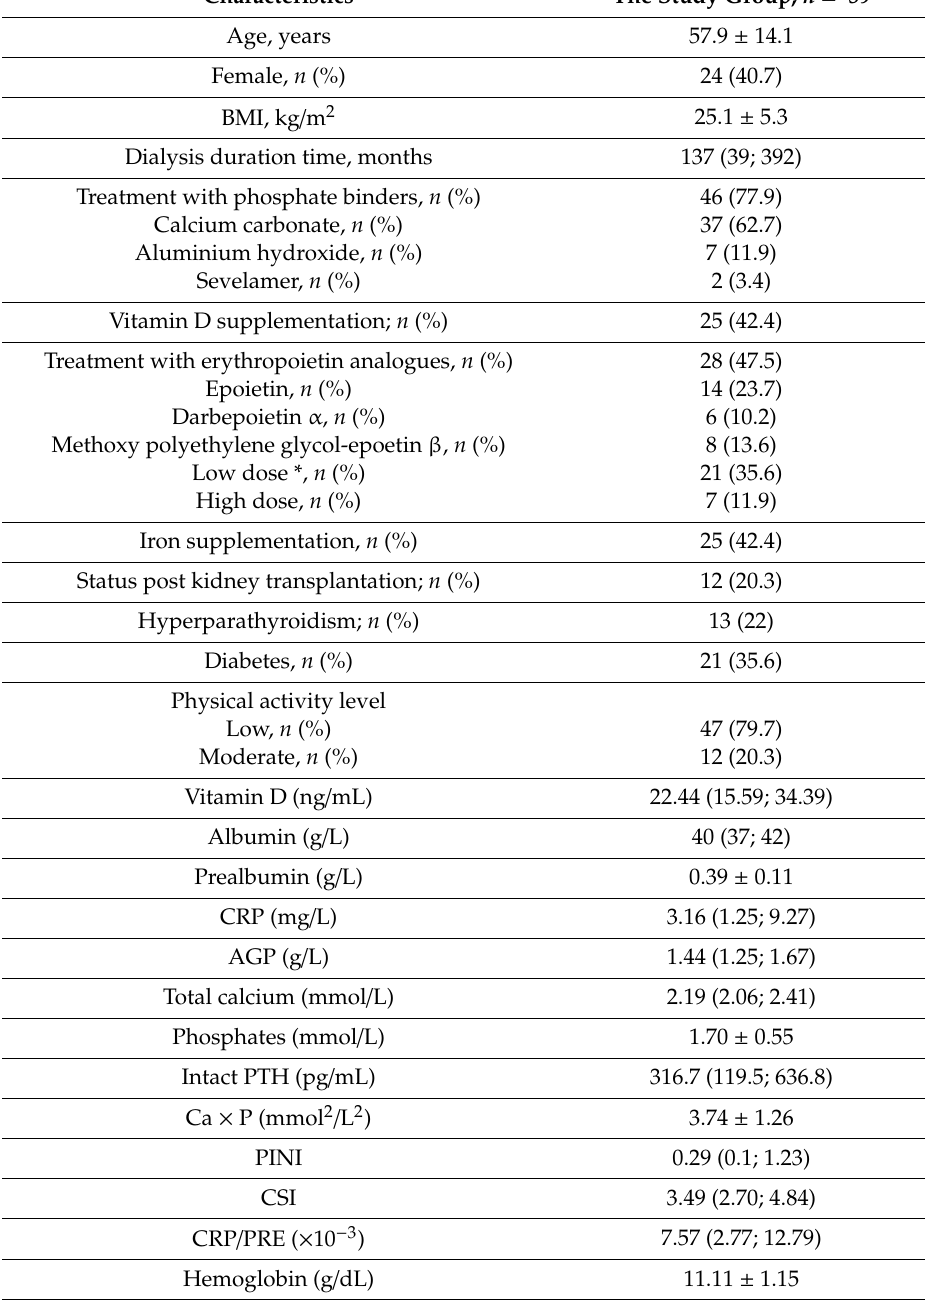
Table 1. Clinical characteristics and laboratory parameters of the study group recorded in the post-summer period. Quantitative data are shown as mean ± standard deviation or median (lower; upper